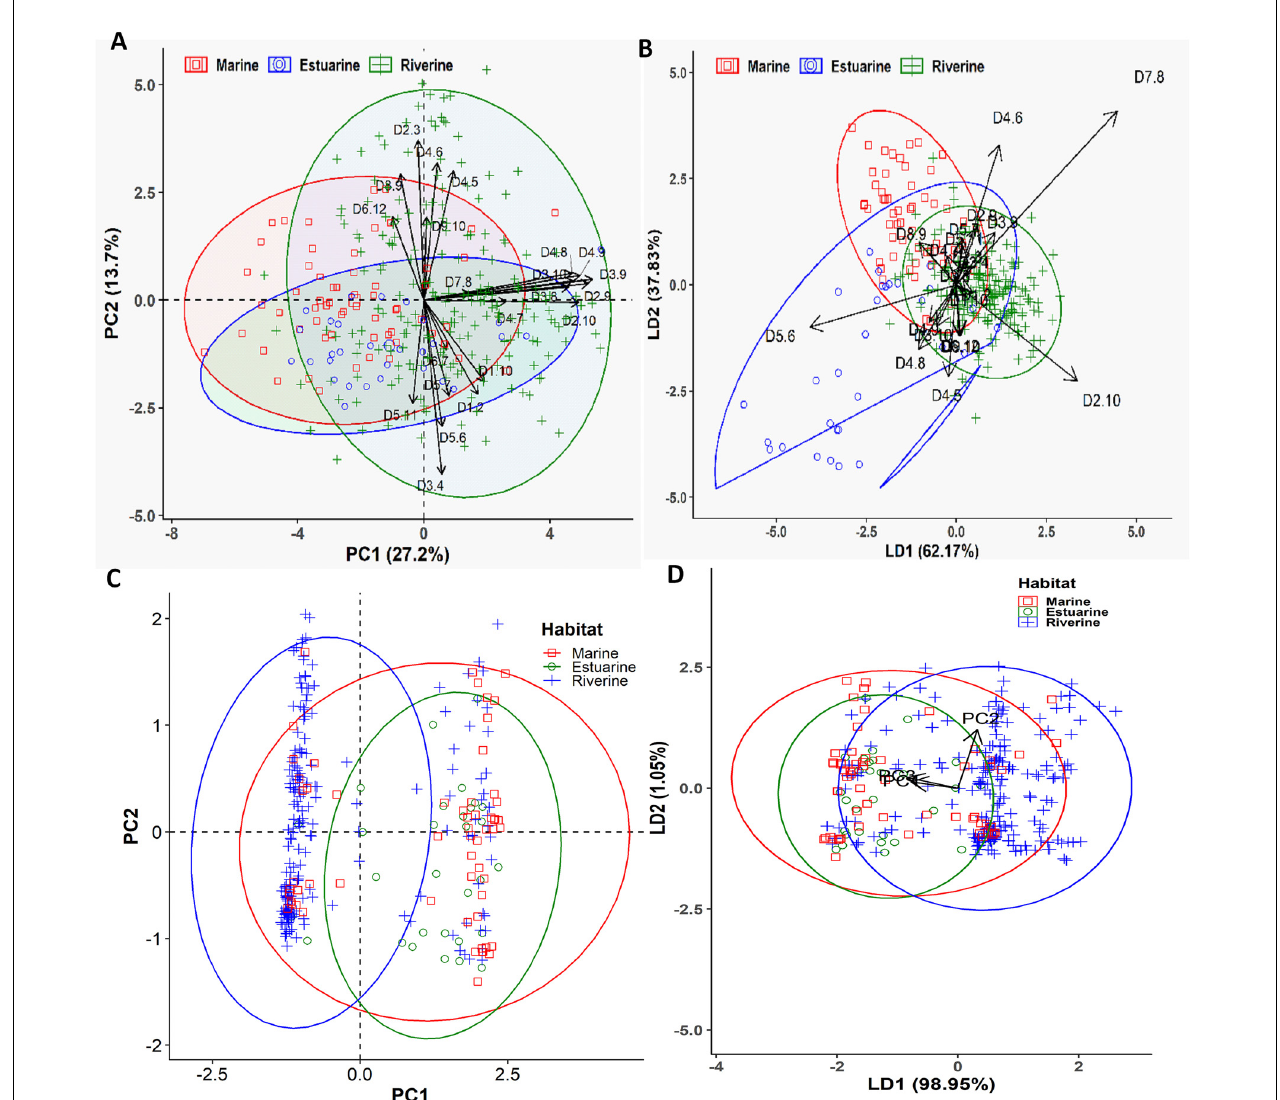
FIGURE 3 | The Principal Component Analysis (PCA) and Linear Discriminant Function Analysis (LDFA) showing the morphogenetic variation of Hilsa shad Tenualosa ilisha collected from the marine (salinity 30.3–33.4 ppt), estuarine (salinity 2.5 to 20.6 ppt) and riverine (salinity < 1.0 ppt) habitats. (A) Biplots of the PCA using 22 morphometric distances of Hilsa shad; (B) biplots of the LDFA using 22 truss morphometric distances of Hilsa shad; (C) biplots of the PCA using 74 putatively adaptive panels of SNP loci identified by the F ST OutFLANK approach; (D) biplots of the LDFA using 74 putatively adaptive panels of SNP loci identified by the F ST OutFLANK